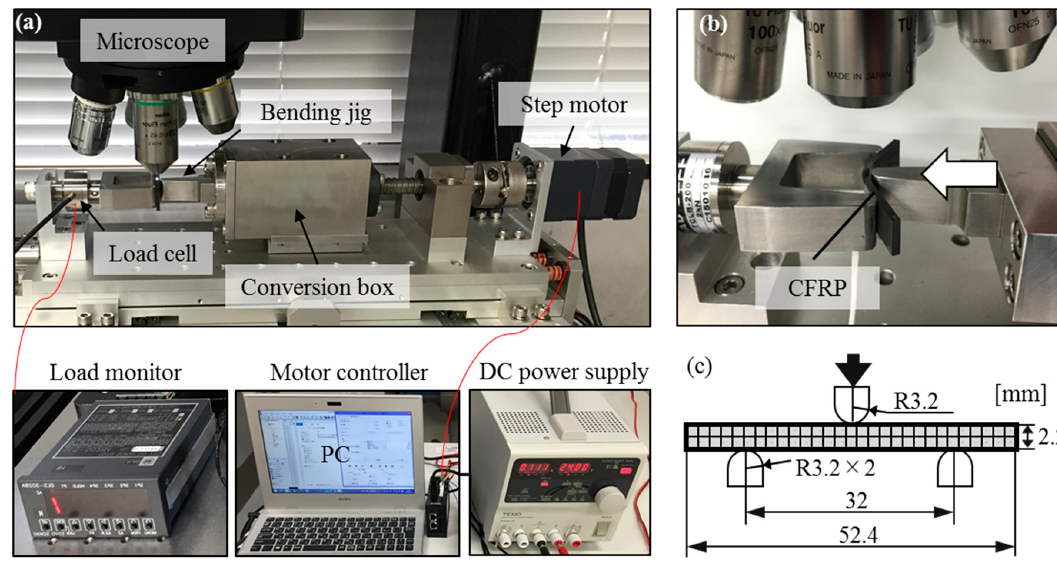
Figure 5. Experimental setup: ( a ) Developed three-point bending device under a laser microscope; ( b ) enlarge image of the loading unit; ( c ) loading size.